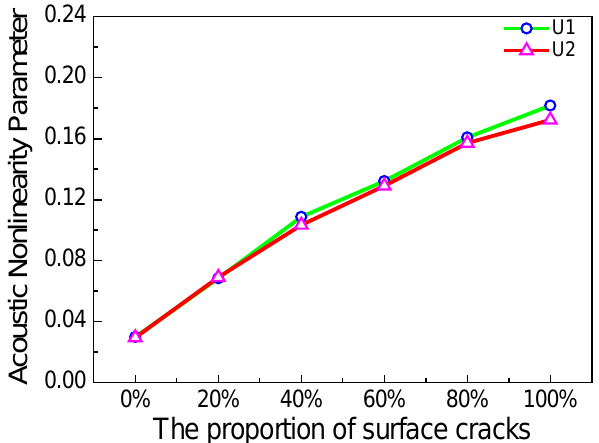
Figure 8. Acoustic nonlinearity parameter versus the proportion of surface cracks ( c = 0.1, f = 1000 kHz, µ = 0.1).